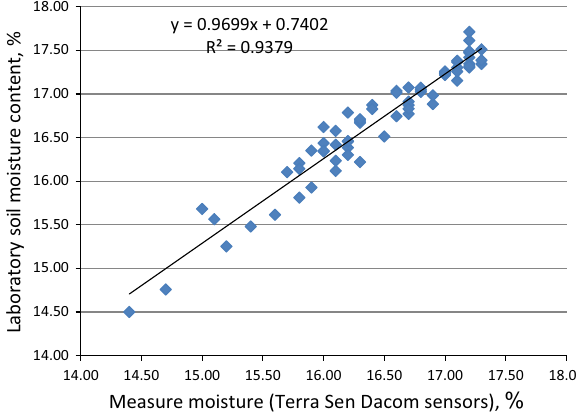
Fig. 2 Relation between laboratory soil moisture content and the measured soil moisture content (Terra Sen Dacom